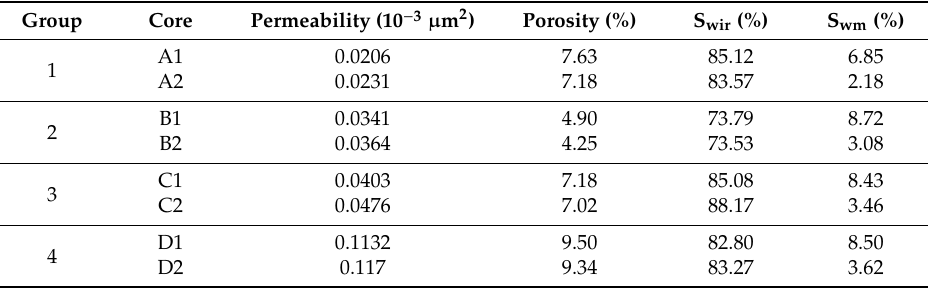
Table 1. Basic properties of sandstone cores used in this study.